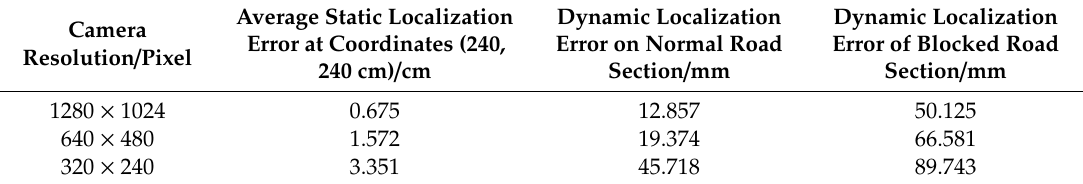
Table 5. Camera localization test results at di ff erent